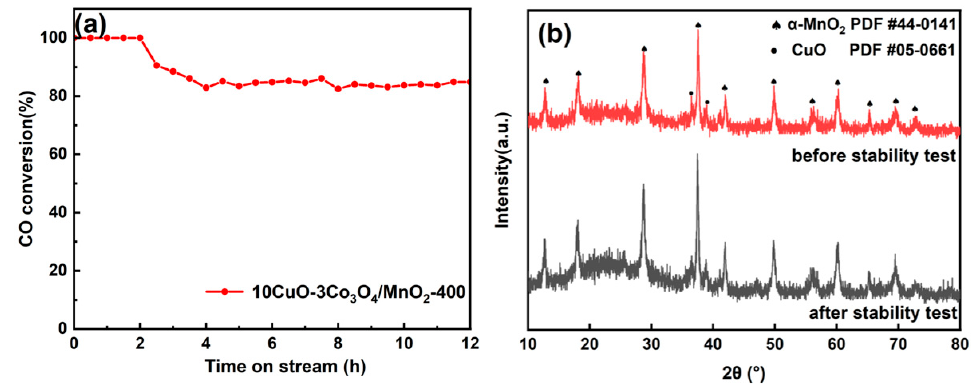
Figure 9. ( a ) The 12 h stability test of CO oxidation over the 10CuO-3Co 3 O 4 / α -MnO 2 -400 catalyst under the conditions: 80 °C, CO/O 2 /N 2 = 1/20/79, GHSV = 12,000 mL·g − 1 ·h − 1 , 1 atm; ( b ) The XRD patterns of the fresh and the spent 10CuO-3Co 3 O 4 / α -MnO 2 -400 catalysts before and after the stability test.